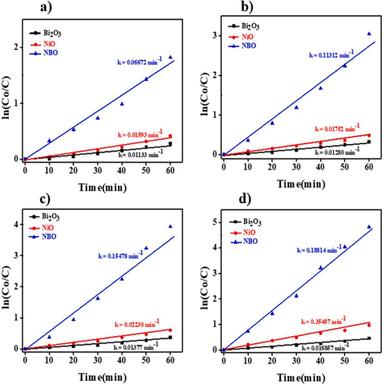
Kinetic plot for MB dye photodegradation various concentration dye a) 20 ppm, b) 15 ppm, c) 10 ppm, d) 5 ppm.